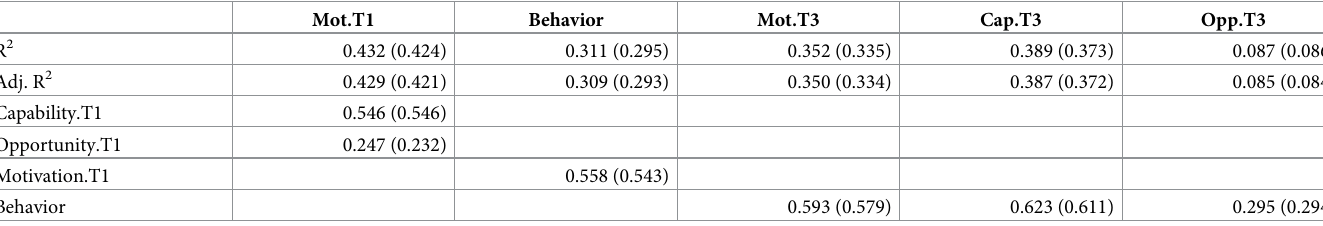
Table 1. Determination coefficient (R 2 ) y Coef. path. Initial model (adjusted model). Mot.T1 Behavior Mot.T3 Cap.T3